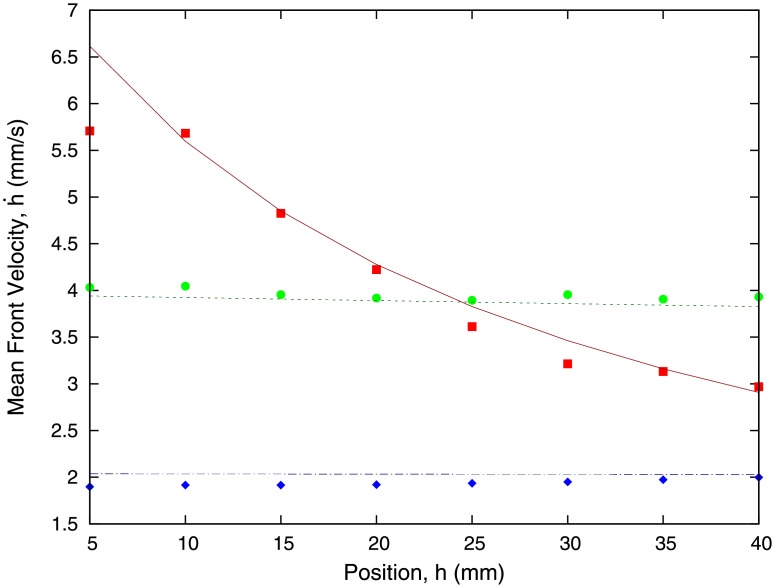
Plot showing the velocity of the front as a function of the position of the front for different heights of the capillary.Experimental results for b = 50 μm (red squares), b = 150 μm (green dots), and b = 300 μm (blue diamonds) are compared to our theoretical model Eq (6). Theoretical results correspond to b = 50 μm (red solid line), b = 150 μm (green dotted line), and b = 300 μm (blue dot-dashed line).